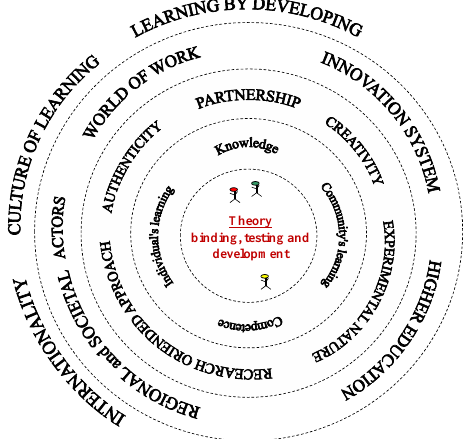
Figure 1. Dimensions of Learning by Developing